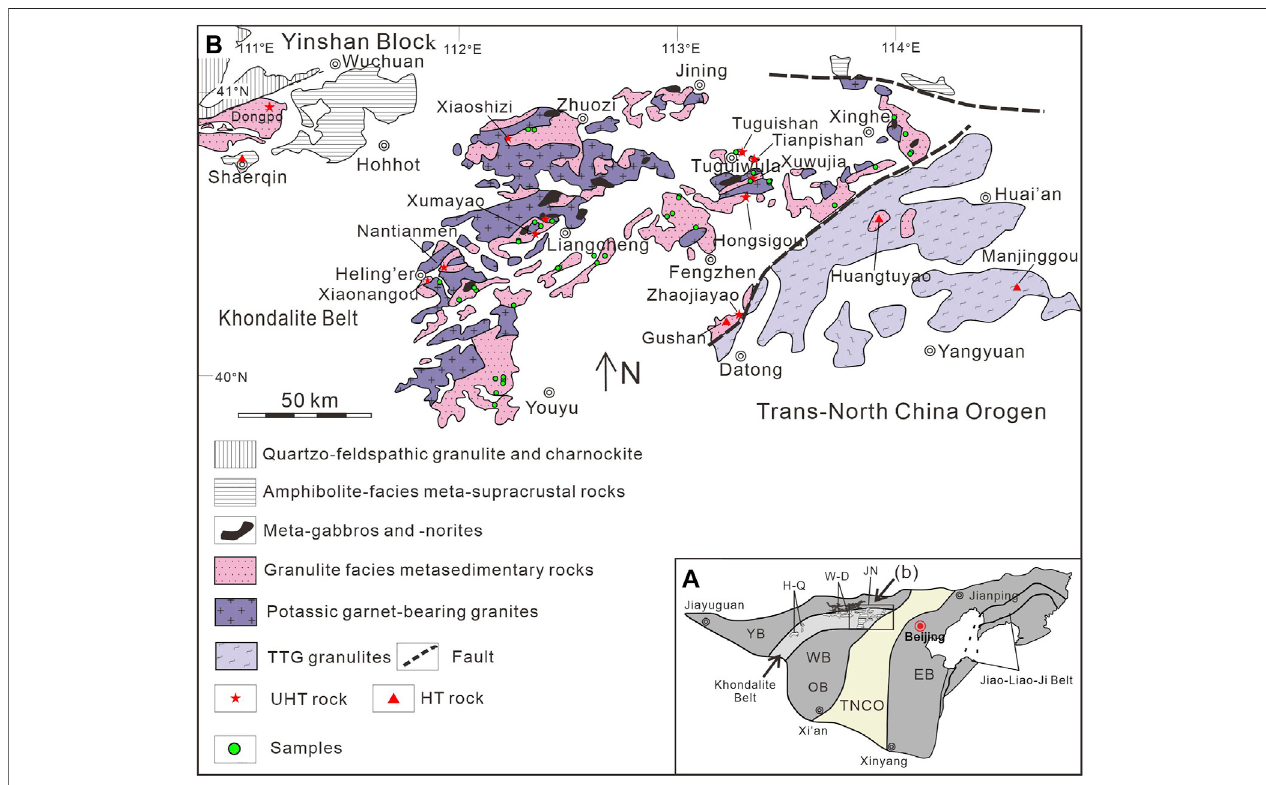
FIGURE 1 | (A) Tectonic subdivision of the basement in the North China Craton; (B) Distribution of the exposed rocks in the eastern Khondalite Belt, North China Craton. Samples are distributed throughout the whole research region. Abbreviations of areas: WB, Western Block; EB, Eastern Block; TNCO, Trans-North China Orogen; YB, Yinshan Block; OB, Ordos Block; H-Q, Helanshan-Qianlishan; W-D, Wulashan-Daqingshan; JN,